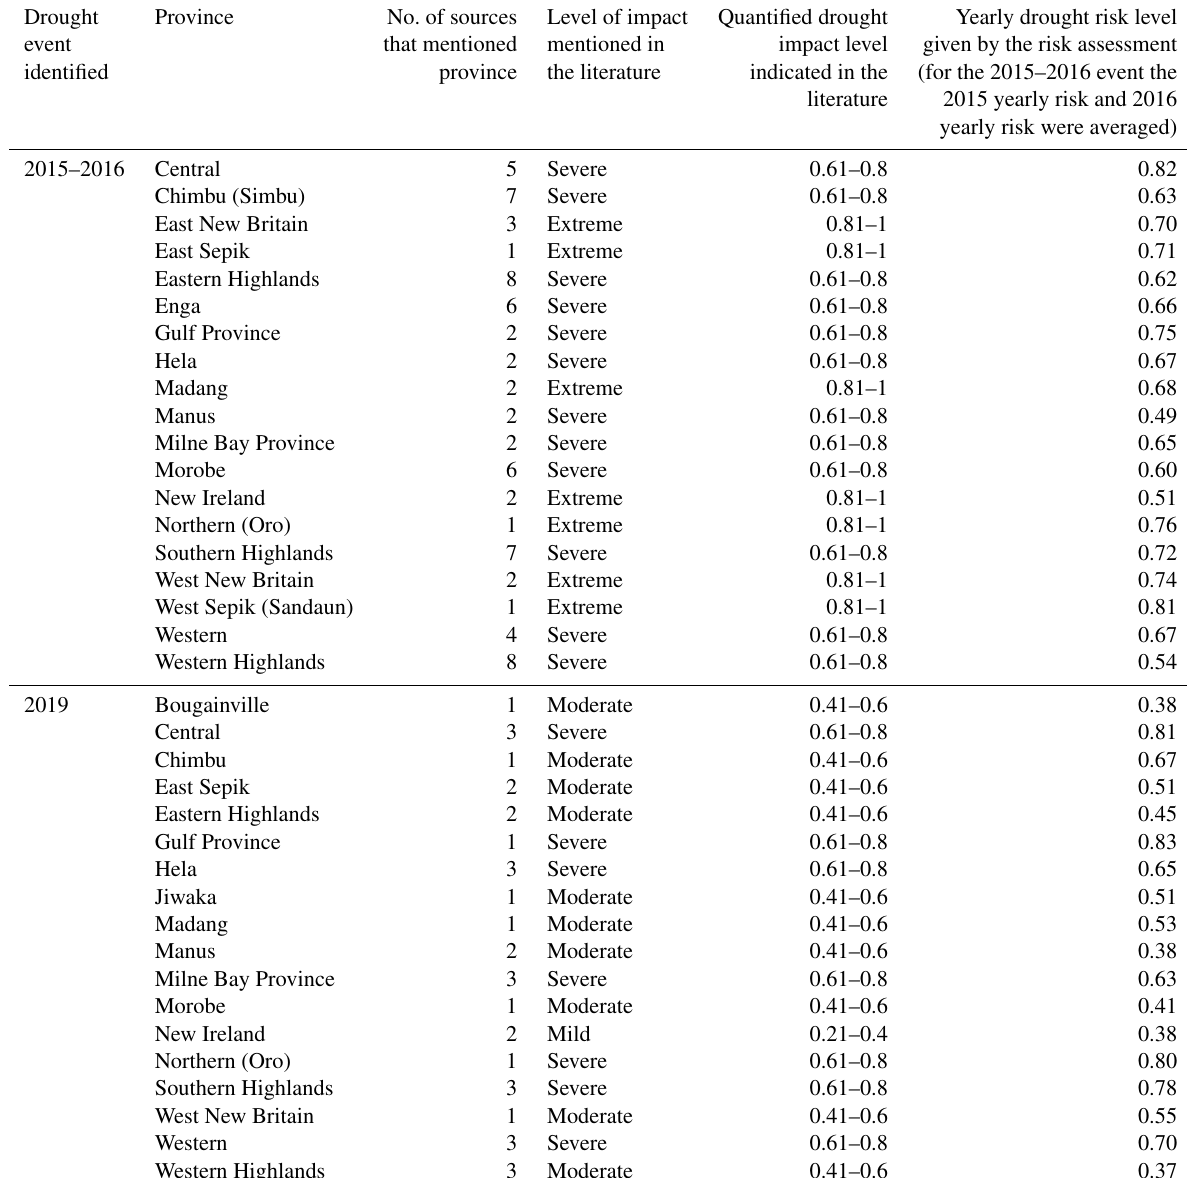
Table 9. Individual PNG province mentions in the literature for each drought event as well as the severity level indicated for each province in the literature. Note that not all 22 provinces were